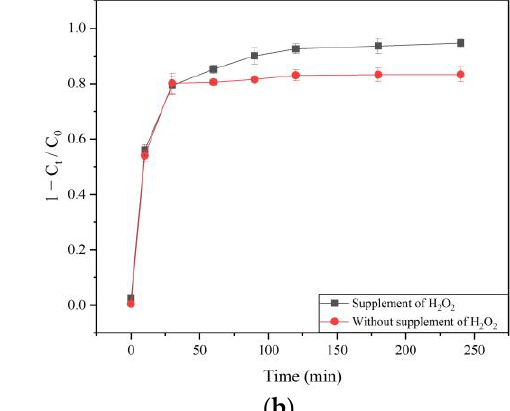
Figure 1. Degradation of tetracycline, residual of H 2 O 2 ( a ), and impact of H 2 O 2 supplementation ( b ) in MnP system.